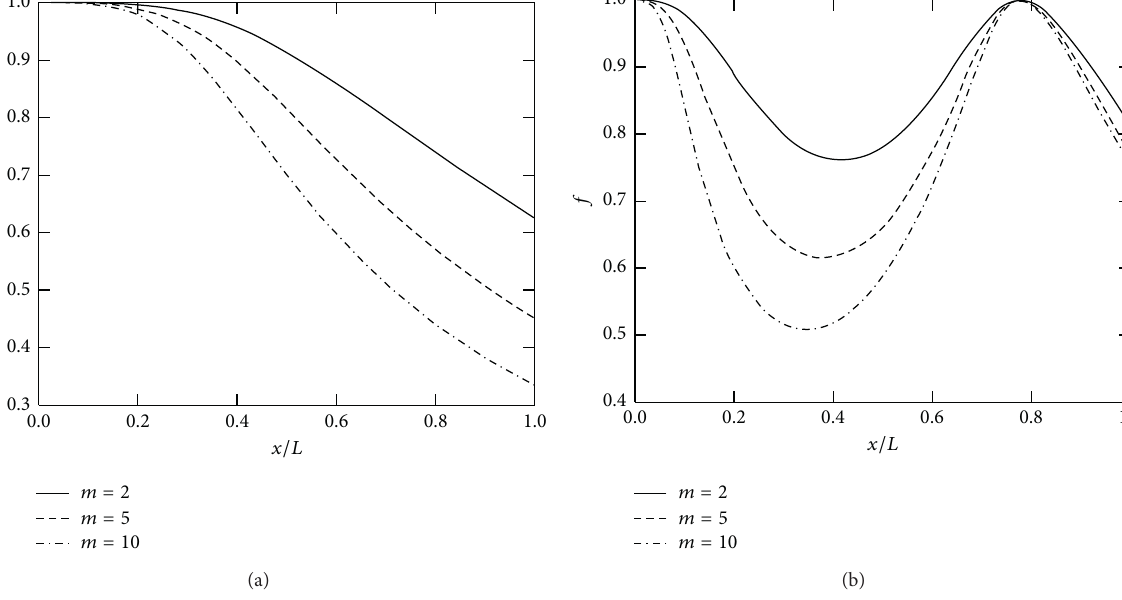
Figure 8: The first two normalized natural frequencies of clamped-simple Timoshenko beam subjected to a moving mass with different